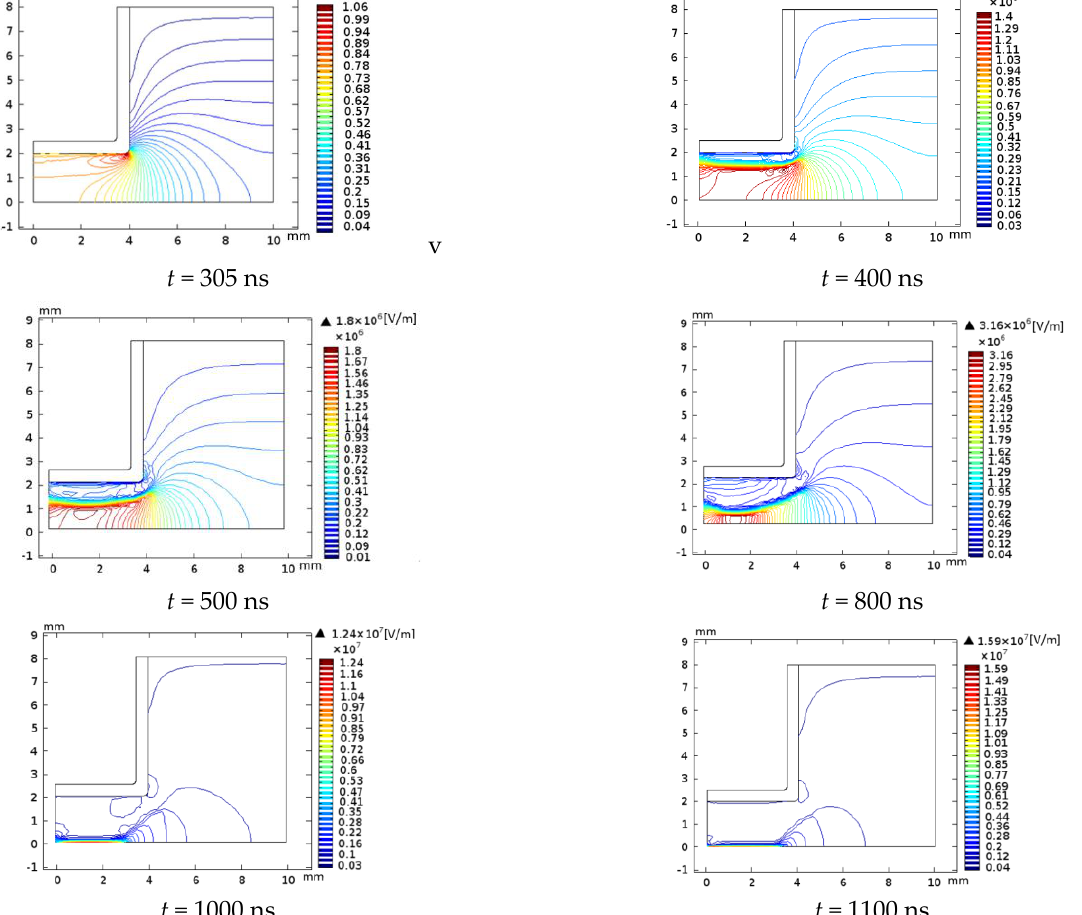
Figure 6. Electric field strength distribution between the electrodes of the FE-DBD argon plasma for different instants of the rising edge of pulse discharge supplied at an applied voltage of 10 kV, a frequency of 10 kHz, and pulse duration 1 µs (t = 305 ns, 400 ns, 500 ns, 800 ns, 1000 ns, and 1100 ns).